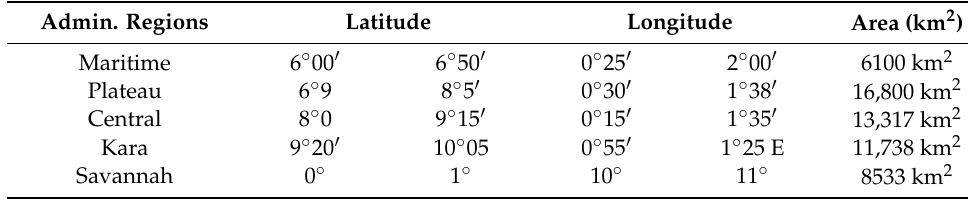
Table 1. Geographic coordinates of the Togolese Administrative Regions. Admin. Regions